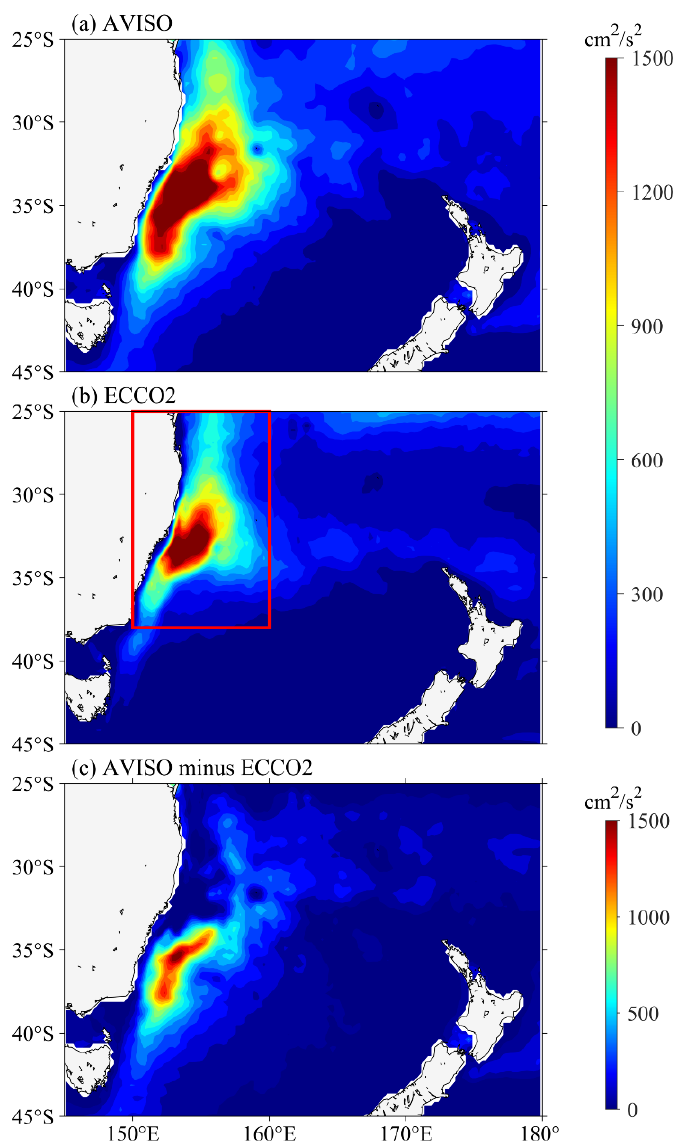
Figure 2. Climatology eddy kinetic energy (EKE) distributions calculated from surface velocities of ( a ) AVISO and ( b ) ECCO2. ( c ) shows the distribution of AVISO EKE minus ECCO2 EKE. Red box indicates the area in which EKE time series and budget are calculated.